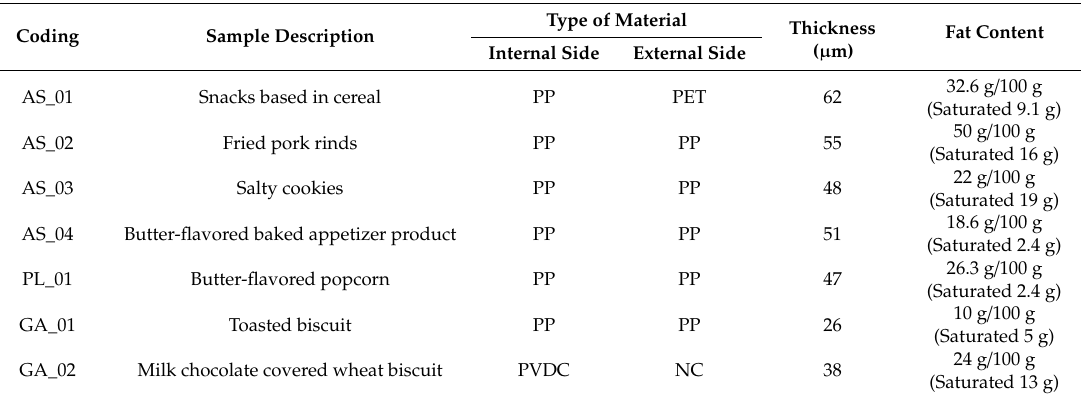
Table 2. Information of food packaging